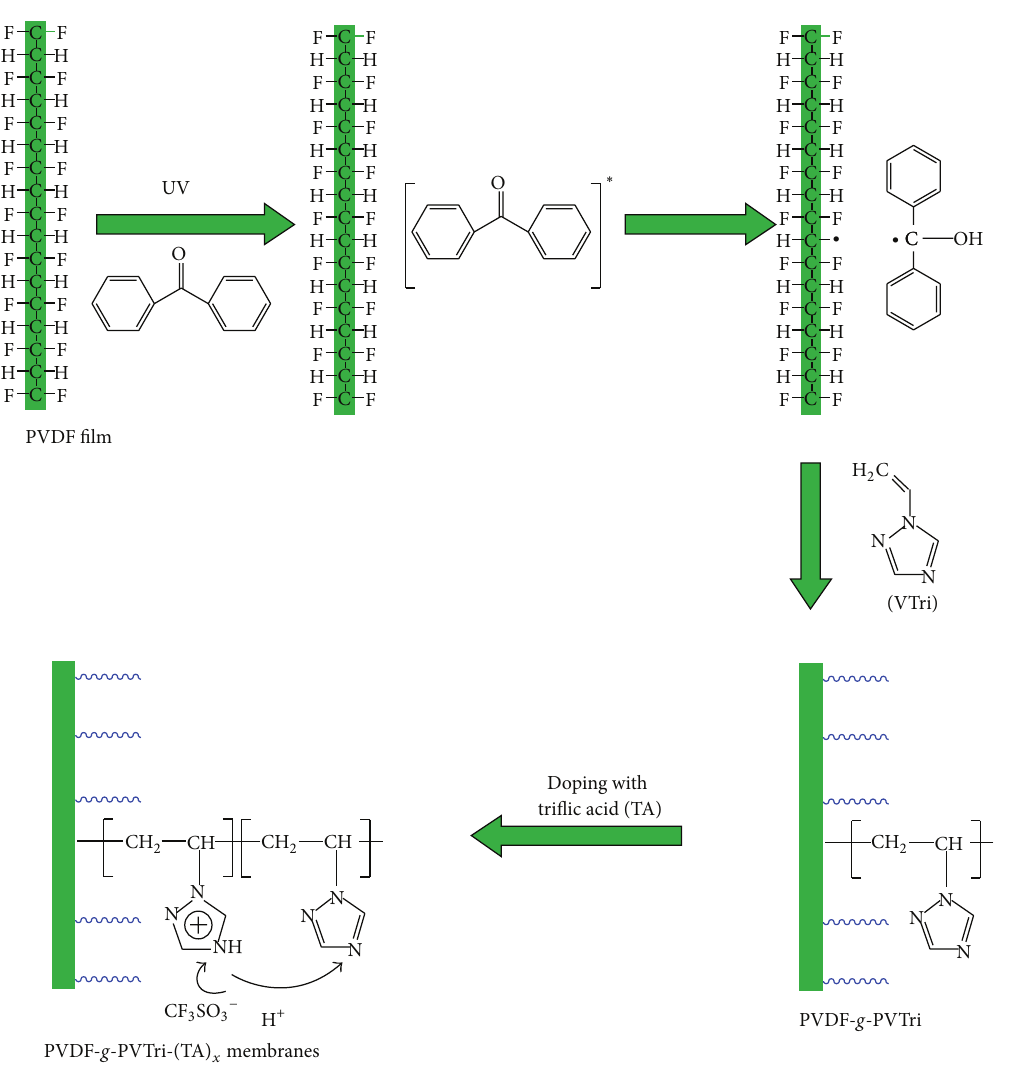
Figure 1: Process for the synthesis of PVDF- g -PVTri-(TA) 𝑥 PEMs by UV surface photografting.